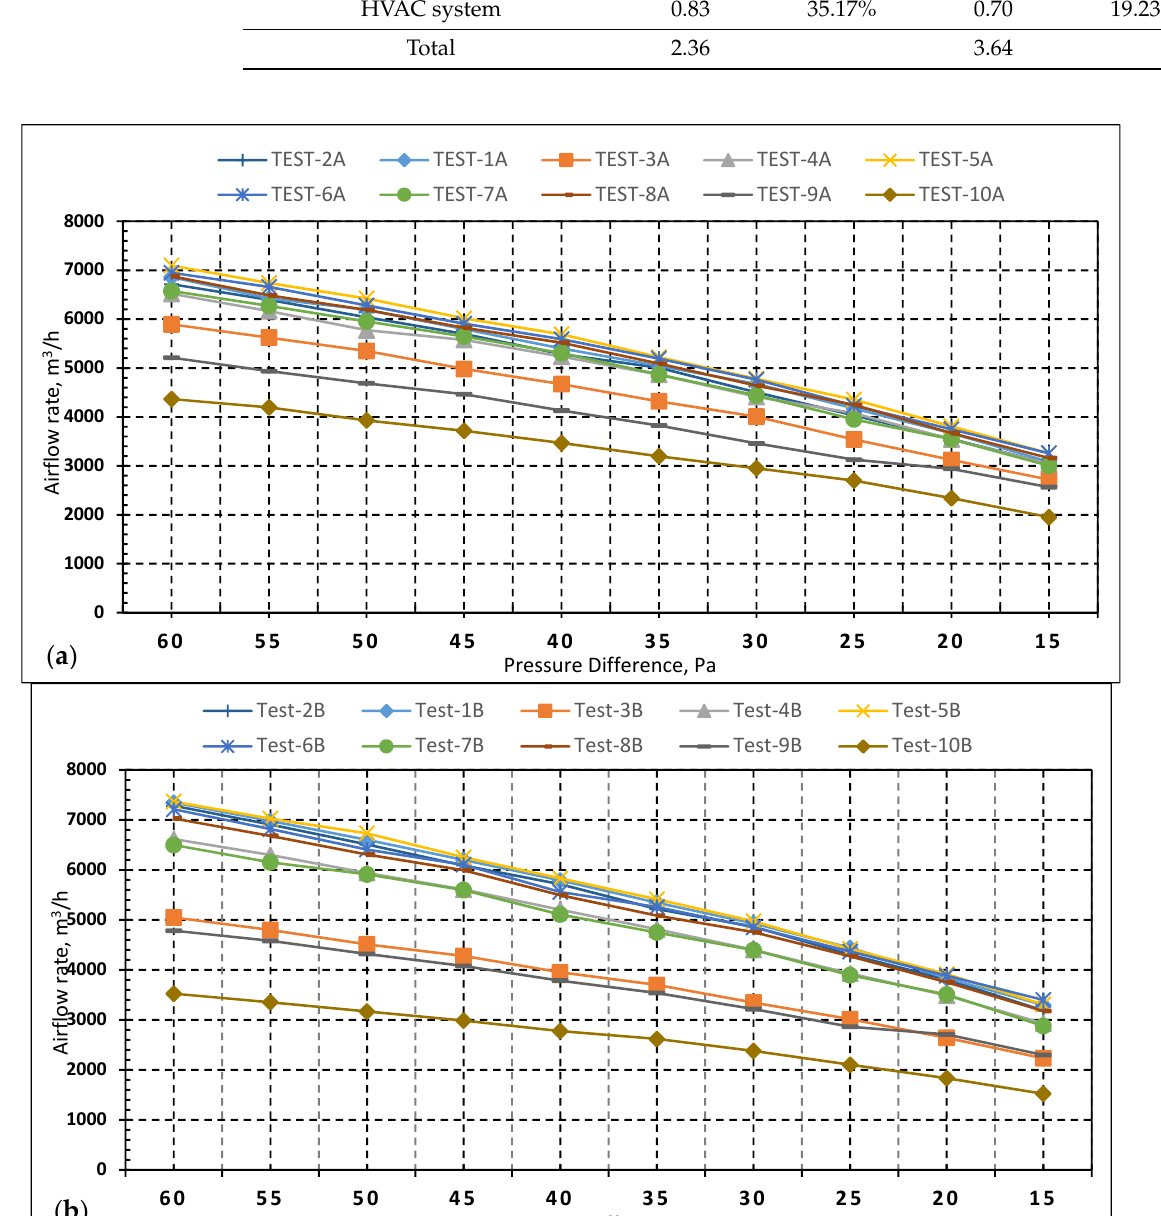
Figure 11. Air leakage graphs ( a ) House A, ( b ) House